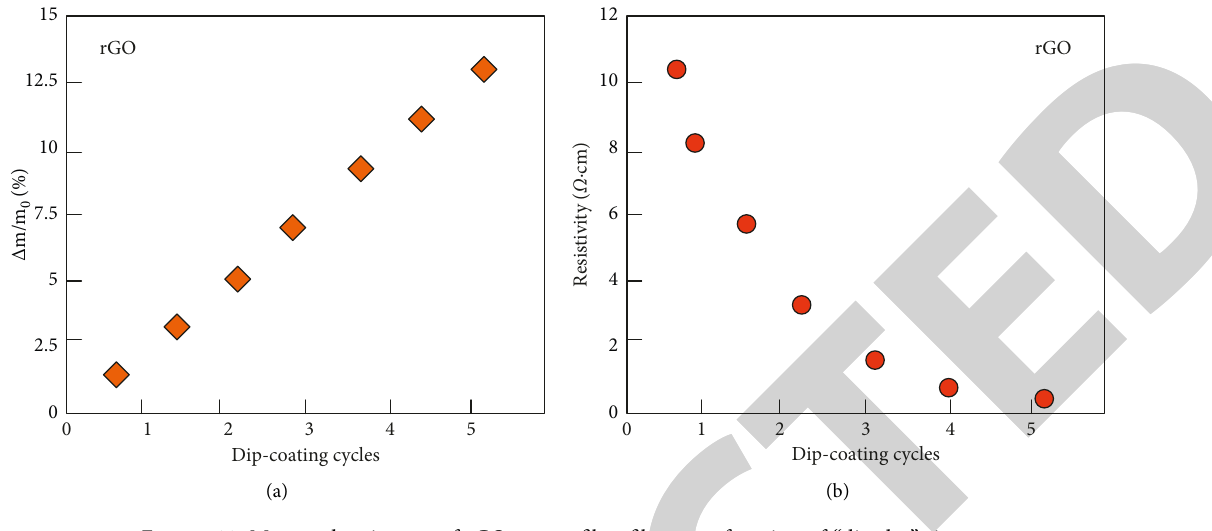
Figure 11: Mass and resistance of rGO cotton fiber films as a function of “dip-dry” time. Table 1: The proportion of elderly self-assessed that exercise helps their health ( n �